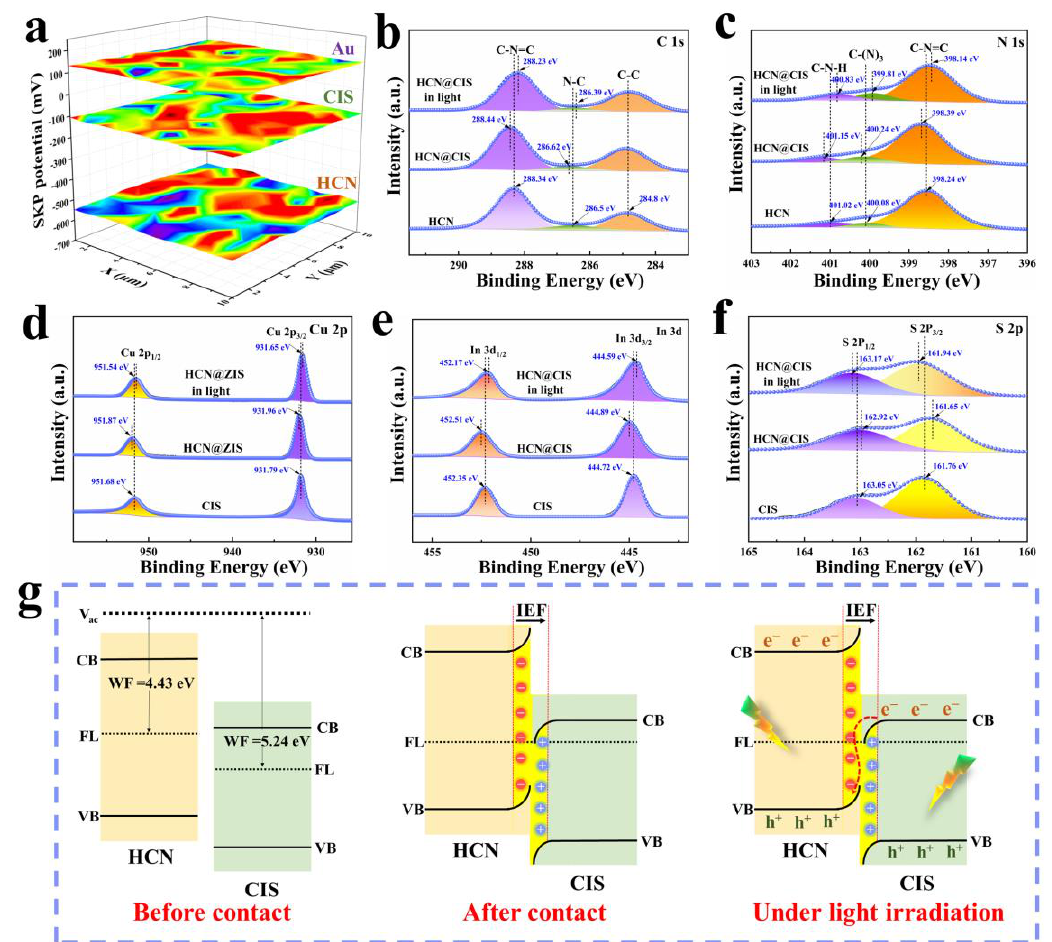
Figure 3. ( a ) Work functions of the HCN and the CIS. XPS spectra of C 1 s ( b ) and N 1 s ( c ) of the HCN and the HCN@CIS. XPS spectra of Cu 1 s ( d ), In 2p ( e ), and S 1 s ( f ) of the CIS and the HCN@CIS. Schematic representation of the formation process and charge transfer mechanism of the HCN@CIS S-scheme heterojunction ( g ).